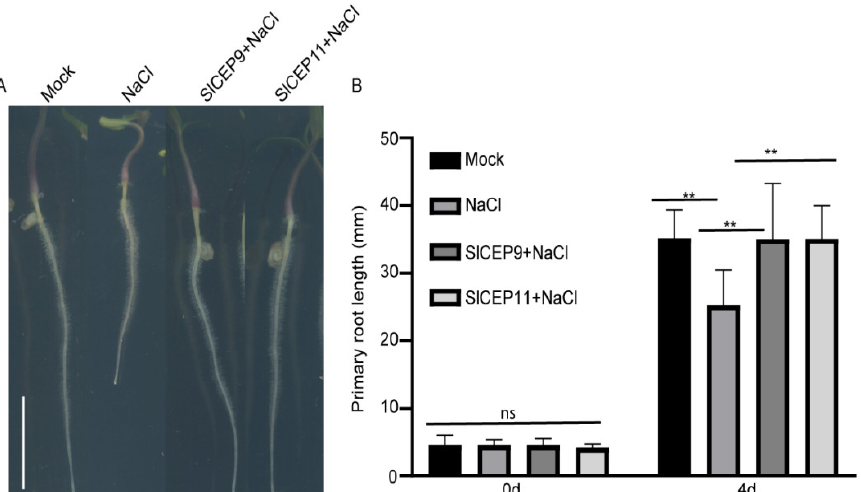
Figure 6. SlCEP9 and SlCEP11 promote tomato root growth under NaCl treatment. ( A ) Representative images showing salinity treated tomato primary roots for 4 days. ( B ) Quantification of tomato primary root length upon synthetic SlCEP9 and SlCEP11 peptide treatment in presence of 100 mM NaCl for 4 days. n = 10–15 seedlings, data represent mean ± SD, ** p < 0.01 was determined by one-way ANOVA. Scale bar = 1 cm. ns: no significance.